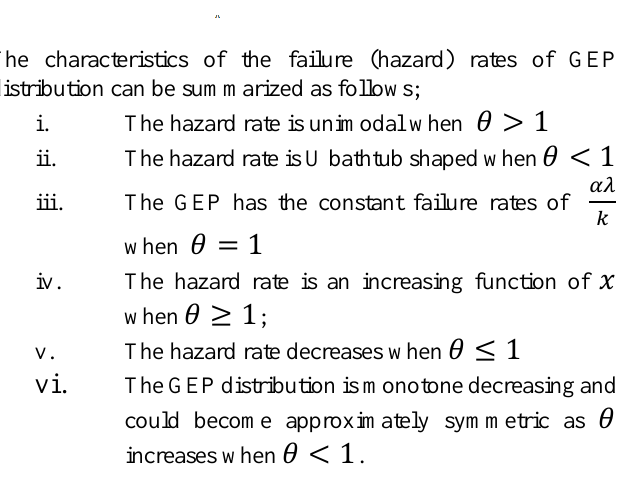
Fig. 4. The failure rates for some arbitrary values of the